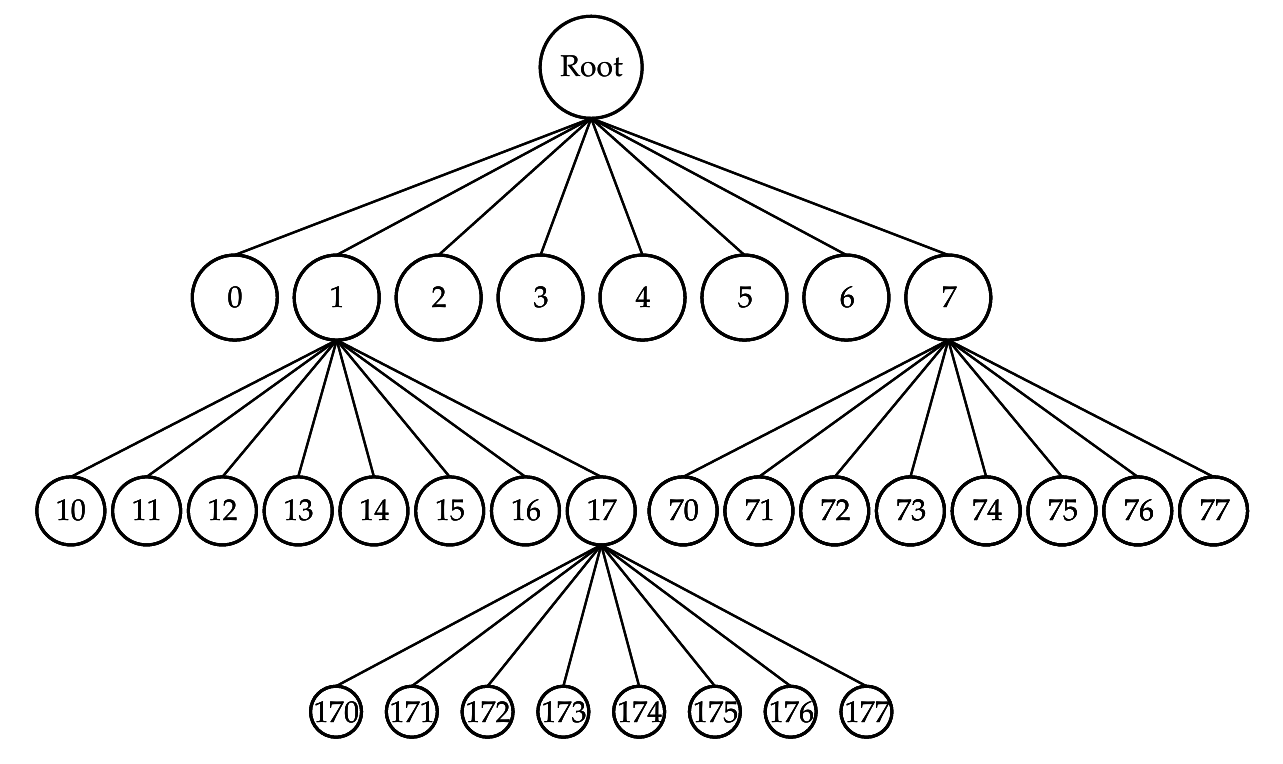
Figure 2. Morton-code encoding octree’s